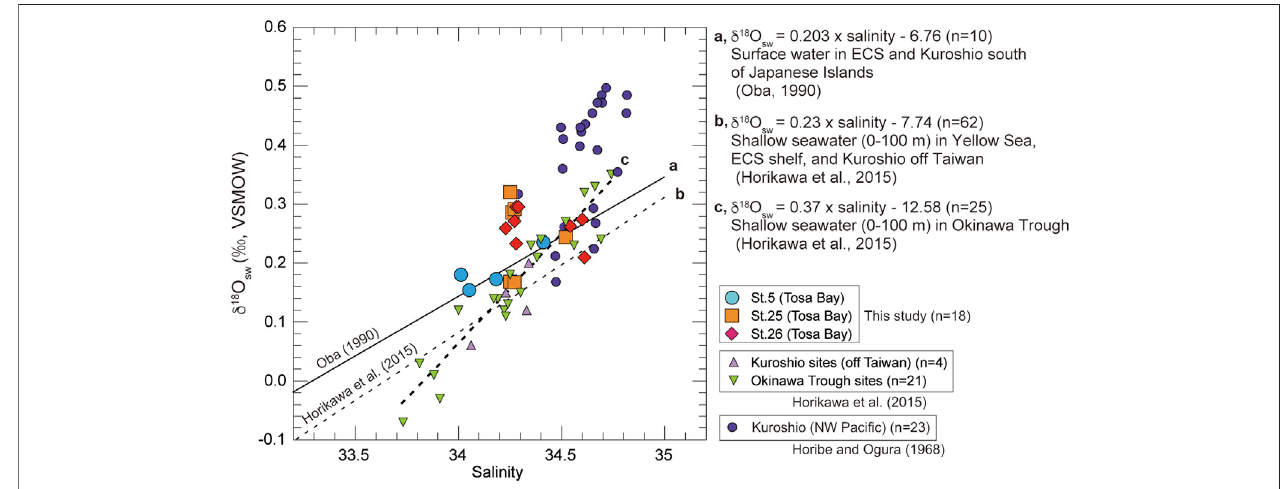
FIGURE 4 | Plot of seawater δ 18 O sw against salinity (0 – 200 m) in Tosa Bay during November and published data from other northwest Paci fi c and East China Sea sites.Regressionline (A) isderivedfromsurface-waterdataintheEastChinaSeaandtheKuroshiosouthoftheJapaneseIslands(Oba1990).Regressionline (B) isfrom shallow water (0 – 100 m) data in the Yellow Sea, East China Sea, and the Kuroshio off Taiwan (Horikawa et al., 2015). Regression line (C) is derived from shallow water (0 – 100 m) data in the Okinawa Trough (Horikawa et al., 2015). Equations from the literature are also shown. Equation of regression line c is calculated from data in the Okinawa Trough sites in Horikawa et al. (2015). End-member data for the Kuroshio are from northwest Paci fi c (Horibe and Ogura 1968).